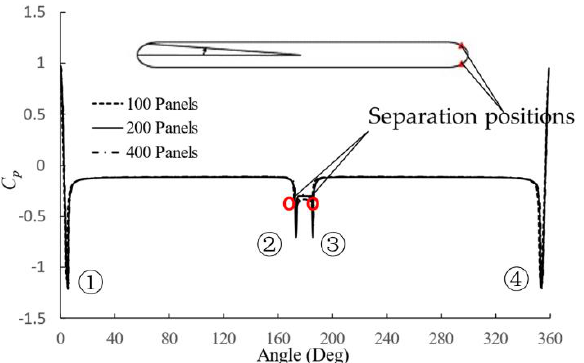
Figure 9. Pressure distribution on the train with different panel densities without the ground. Like the symmetrical simulation of the cylinder flow above, the generic train is